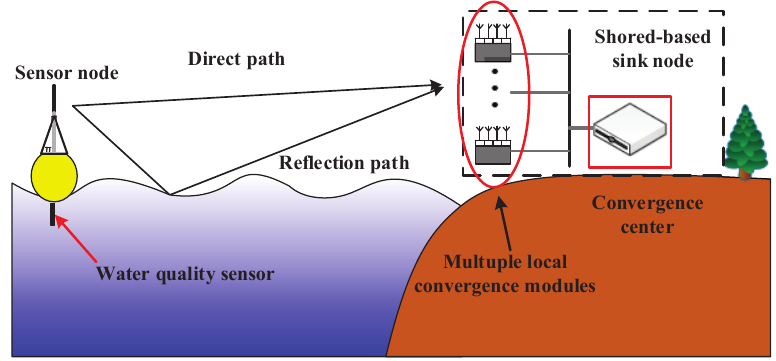
Figure 1. Proposed maritime wireless sensor networks